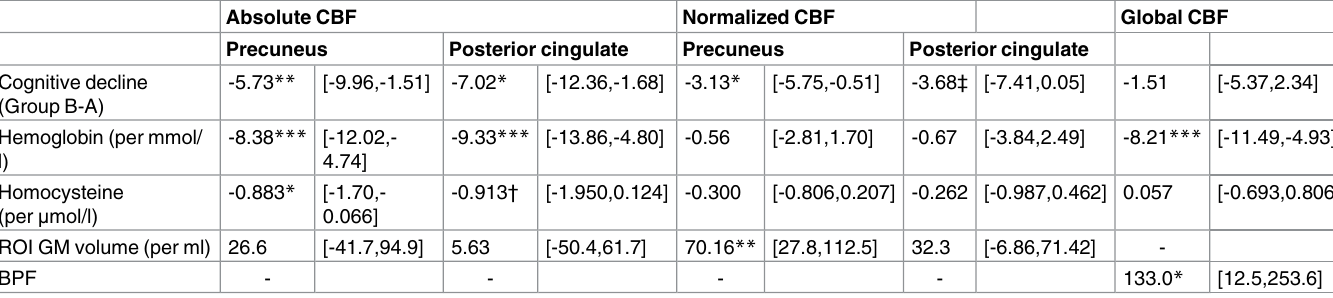
Table 3. The association ( β coeffiecents) of subclinical cognitive decline with regional and global cerebral blood